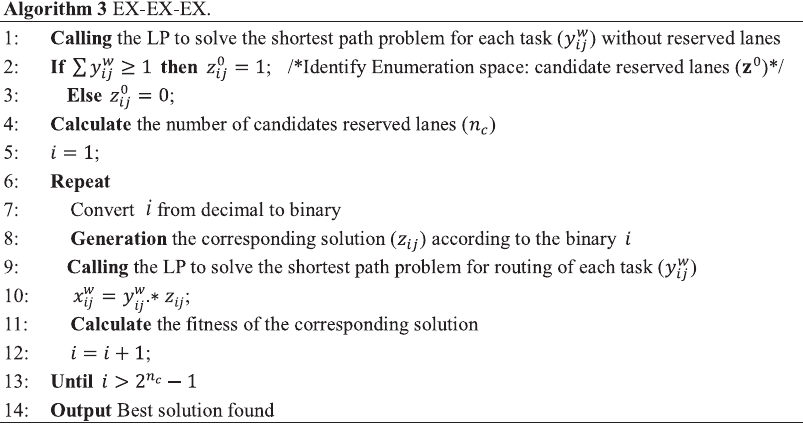
Figure 6: Pseudocode of EX-EX-EX for BHLRP. Table 3: Generating the instance problems for the proposed model.